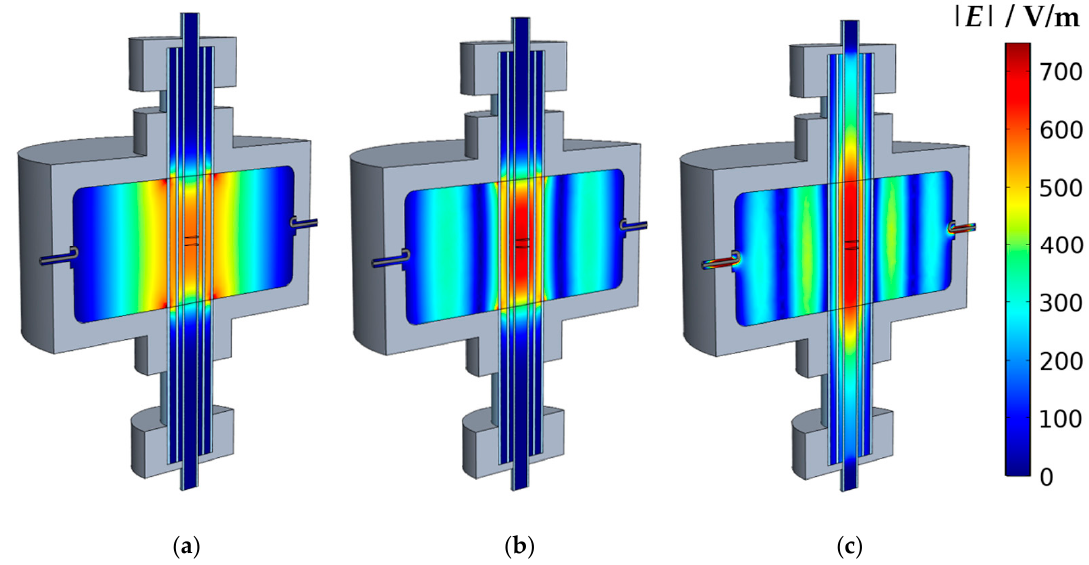
Figure 2. Simulated electric field inside the empty resonator (sectional view): ( a ) TM 010 ; ( b ) TM 020 ; ( c ) TM 030 .